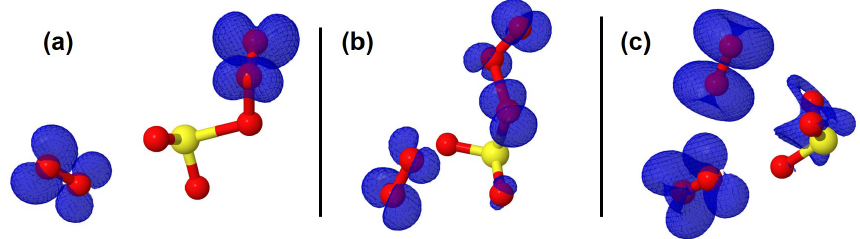
Figure 3. Representation of the spin density (in blue color) on intermediate structures in the O 2 SOO − + O 3 reaction. The spin density clearly indicates that the extra electron is progressively distributed over all the atoms from (a) the pre-reactive complex through (b) the transition state to (c) the product